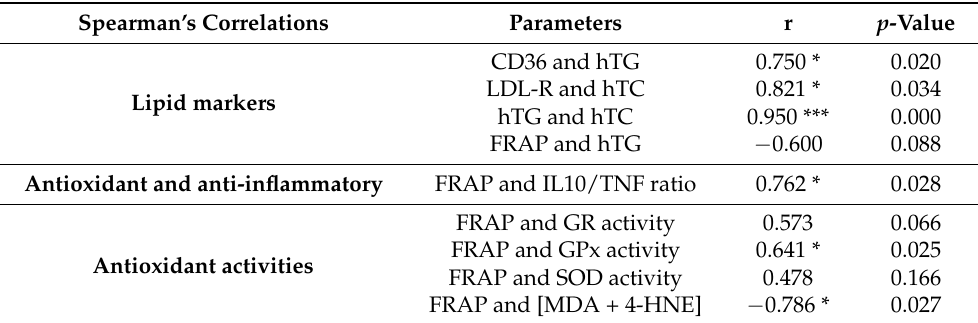
Figure 4. Lipid metabolism markers gene expression. Relative gene expression of scavenger recep- tors (CD36, SR-A), adiponectin receptor II (adipoR2), fatty acid synthase (FASN), and low density lipoprotein receptor (LDL-R) in the liver of mice after 12 week-treatment with LPHs. Data are shown as the mean of 2 − ∆∆ Ct and standard error of the mean of each group ( n =10). * p ≤ 0.05, with respect to the WD group. CD36, cluster of differentiation 36; SR-A, class A macrophage scavenger receptor; WD, western diet group. Table 1. Nonparametric correlations.